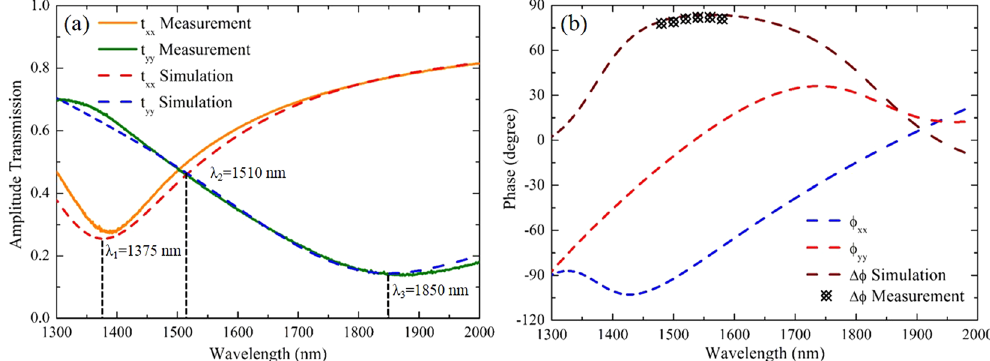
Figure 4. ( a ) Measured and simulated transmission amplitude spectra of t xx and t yy under two orthogonal linear polarization excitations along x and y directions. ( b ) Measured and simulated phase retardation between two orthogonal directions, together with simulated phase shifts φ xx and φ yy